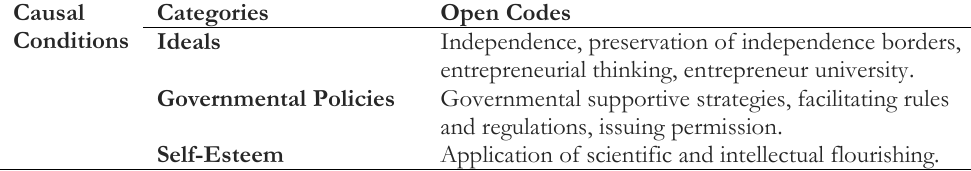
Table 2. Open codes and categories of causal